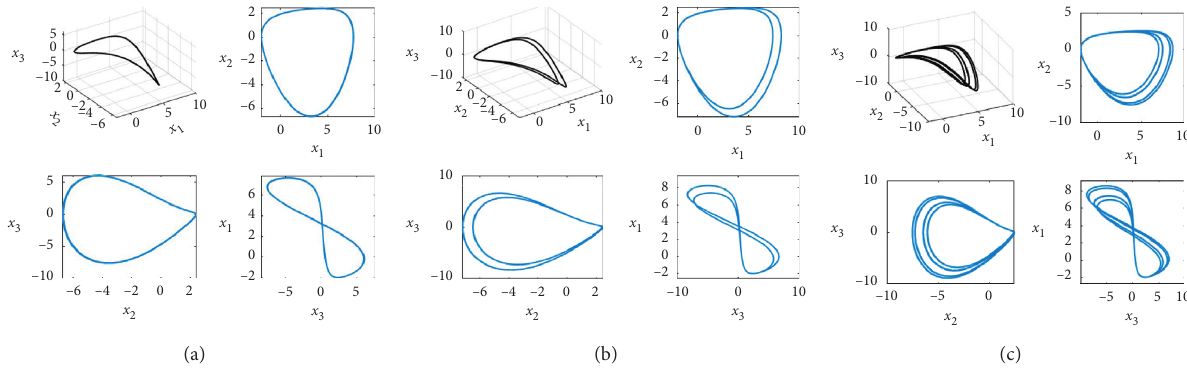
− x − x − x plane, x plane, and x plane. (a) a � 3 :31, b � 1, 1 2 2 3 3 1